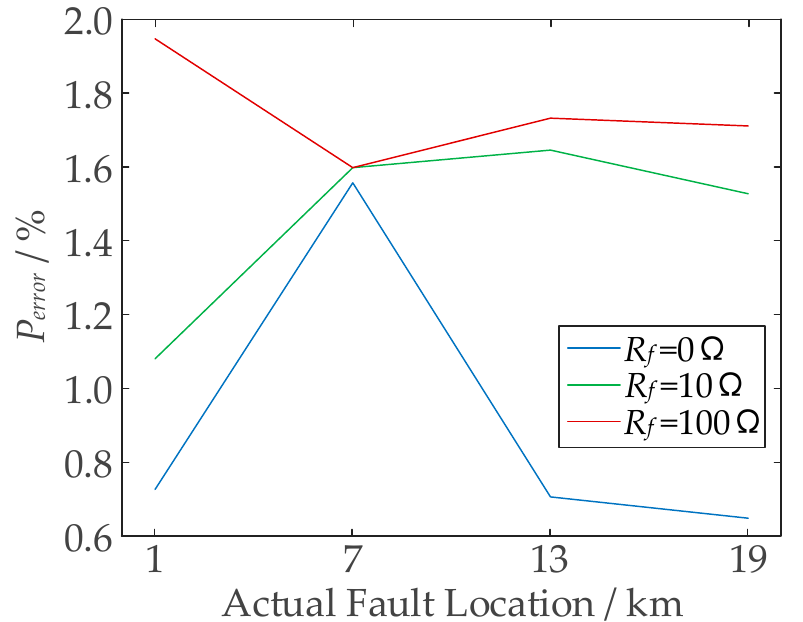
Figure 9. Simulation results for 10 kHz sampling frequency. Table 2. Fault location results for different sampling